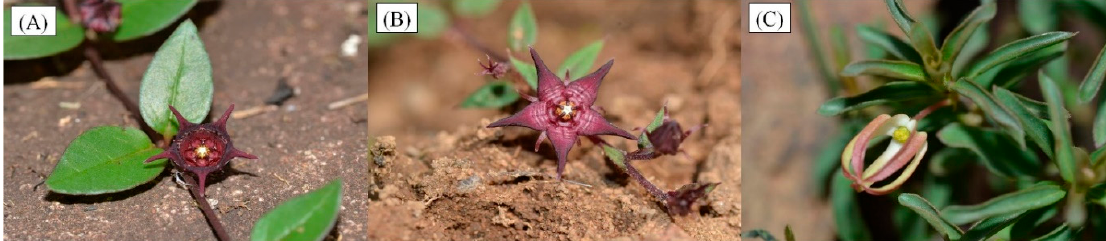
Figure A1. Brachystelma species investigated. ( A ) Brachystelma ngomense . ( B ) Brachystelma pulchellum . ( C ) Brachystelma pygmaeum . (credit: Adam Shuttleworth).